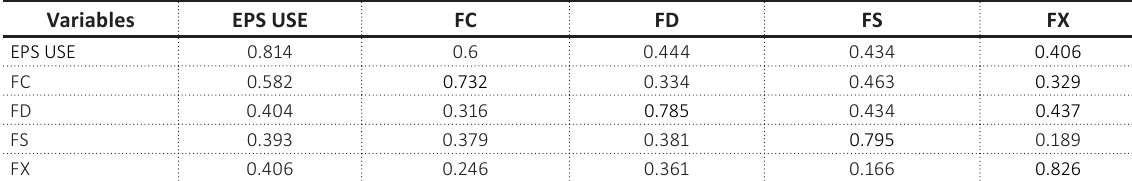
Table 4. Discriminant analysis with the Heterotrait-Monotrait (HTMT) ratio and correlation matrices